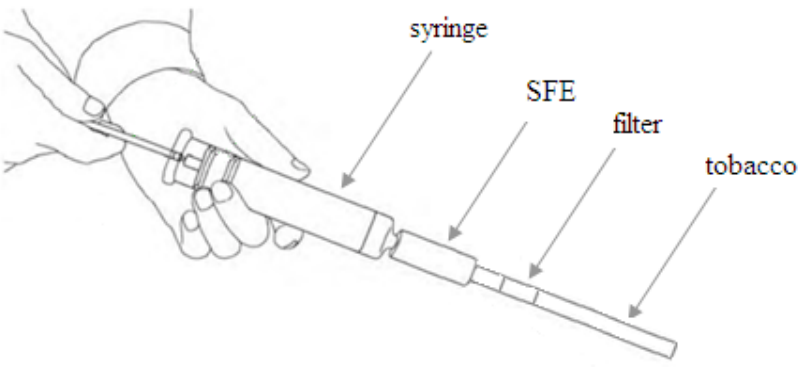
Figure 3. The installation for simulating human